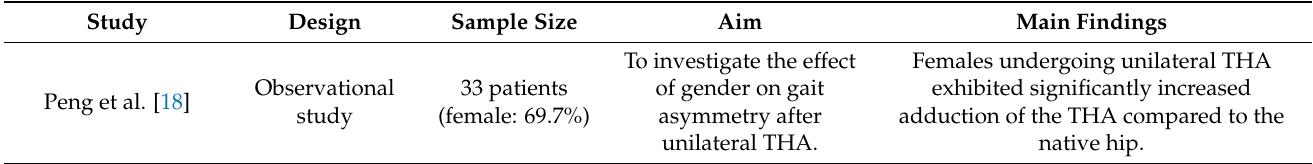
Table 2. Studies dealing with clinical outcomes and complications with regard to sex and